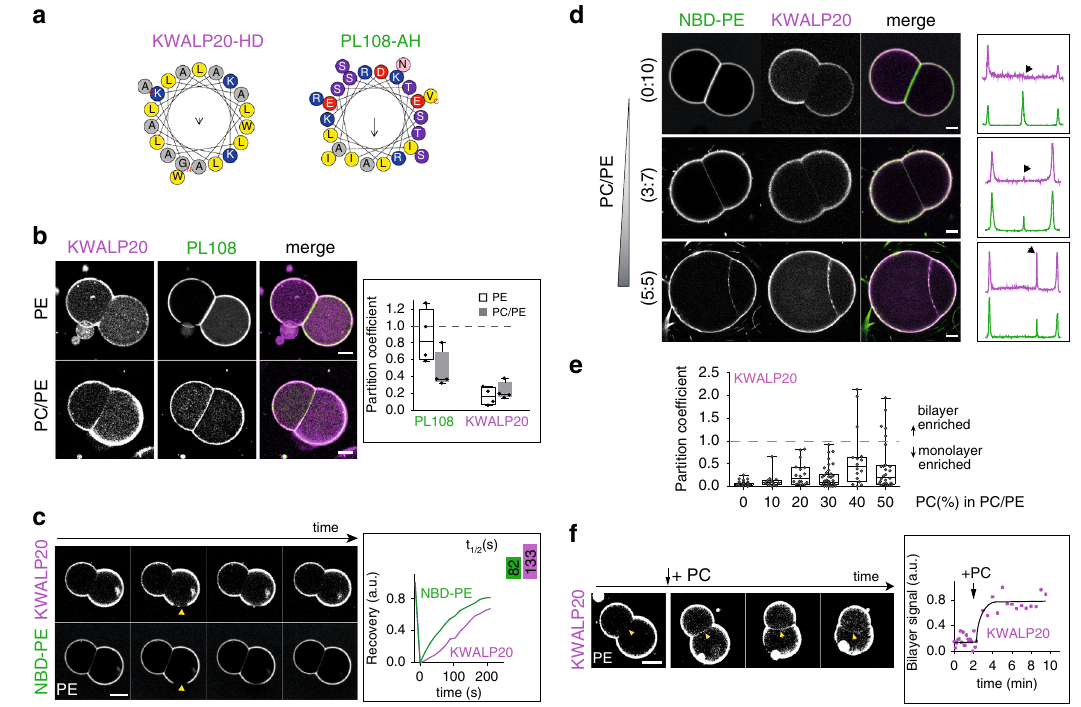
Fig. 3 PC/PE ratio modulates the partitioning of model AH and HD peptides. a Helical wheel representation of KWALP20 and PL108-AH, generated from HeliQuest 69 . b Distribution of KWALP20 and PL108 in DOPE or DOPC/DOPE (1:1) DIBs. KWALP20 is labeled with and PL108 with NBD. Scale bar: 50 µ m. The partition coef fi cient is plotted for both peptides as box-plots (box limits, upper and lower quartiles; middle line, median; whiskers, minimum and maximum value), from n = 4 independent measurements for each condition. Individual data are shown as black dots. c FRAP experiment shows that KWALP20 (purple) and lipid (green) signals are mobile at the monolayer. NBD-PE reports for phospholipids. Yellow arrows indicate the area bleached. Scale bar: 50 µ m. Recovery half-time was obtained using one-phase association fi tting in GraphPad software and is shown in the upper right box. d KWALP20 distribution in DIBs of different PC/PE ratio. Line pro fi les (not displayed) are drawn perpendicular to the bilayer and monolayers (as described in Fig. 2b); the thickness of the line is 30-40% of the bilayer size. The corresponding signals are shown in the box (right); black arrows depict the bilayer signal. Scale bar: 20 µ m. e Partition coef fi cient of KWALP20 in DIBs of different DOPC/DOPE ratios represented as box-plots (box limits, upper and